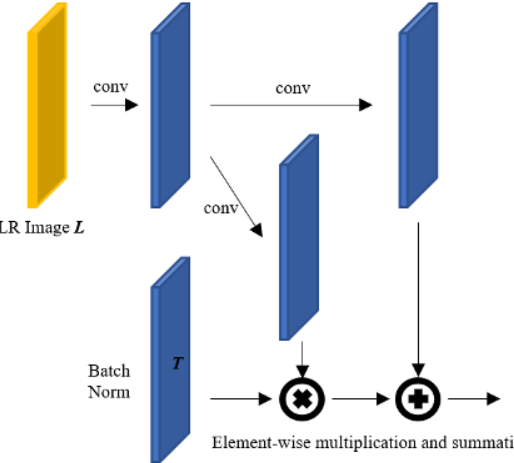
Figure 6. Spatially adaptive denormalization structure for single image super-resolution: From the low-resolution image L and the batch normalization layer T , through the convolution steps and element-wise multiplication and summation, the process obtains the final result to input into G and D .